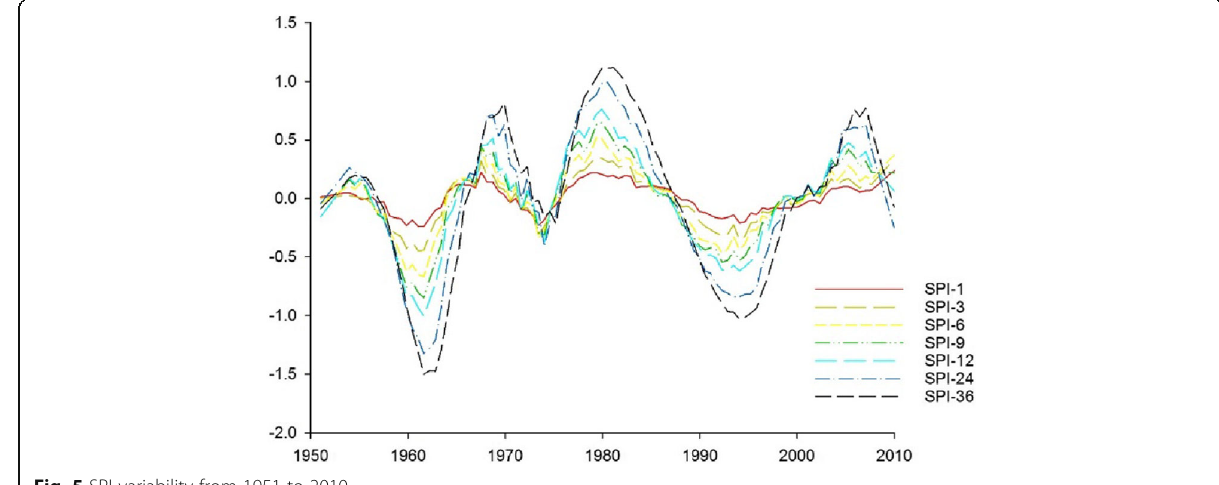
Fig. 5 SPI variability from 1951 to 2010